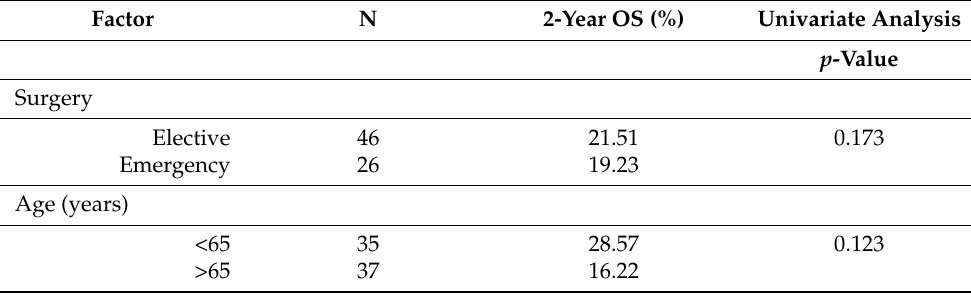
Table A1. Analysis of factors associated with 2-year relapse-free